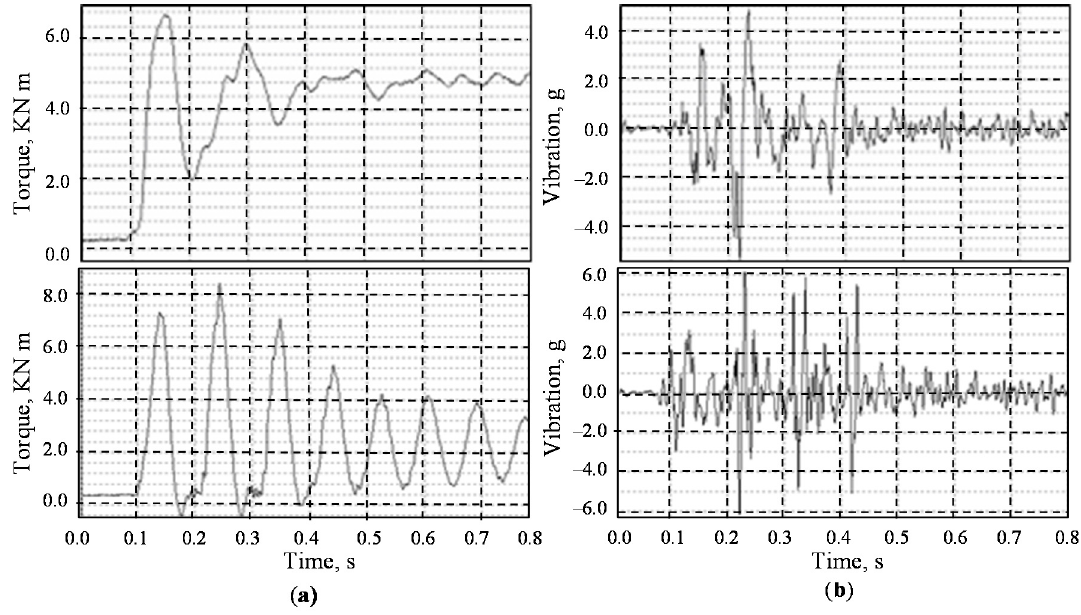
Figure 6. Measurements of torque in the motor shaft ( a ) and vertical vibration on the bearing supports ( b ) of two different gearboxes.